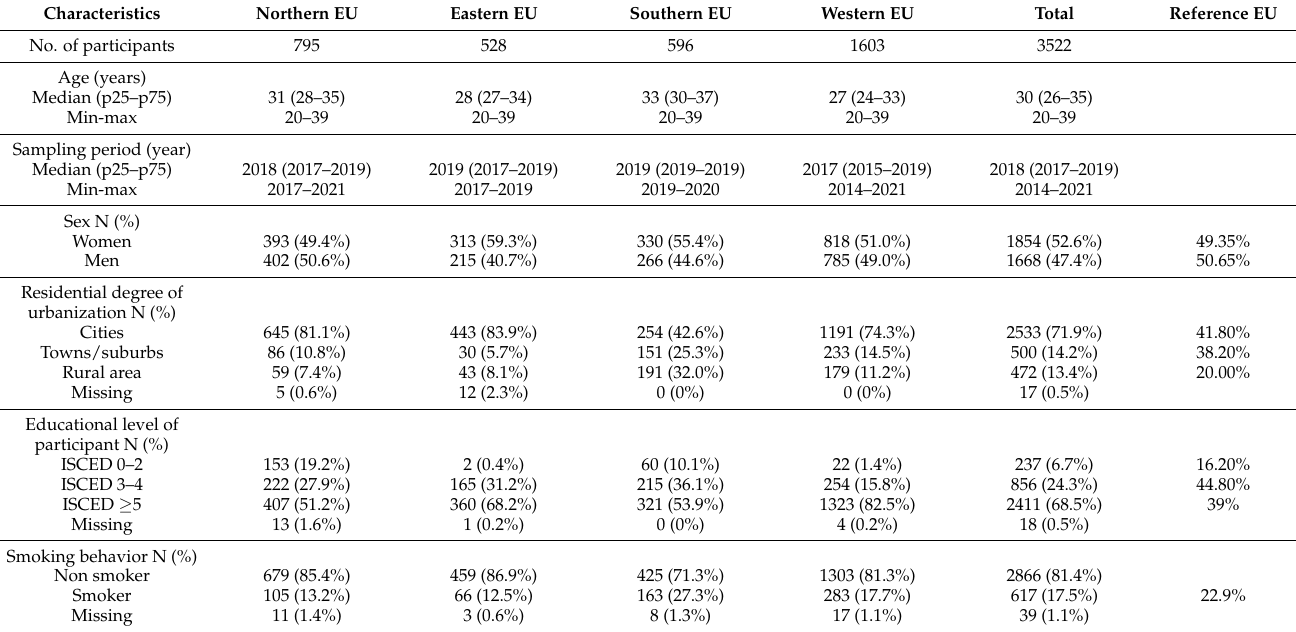
Table 4. Characteristics of sampled population adults by European region and in